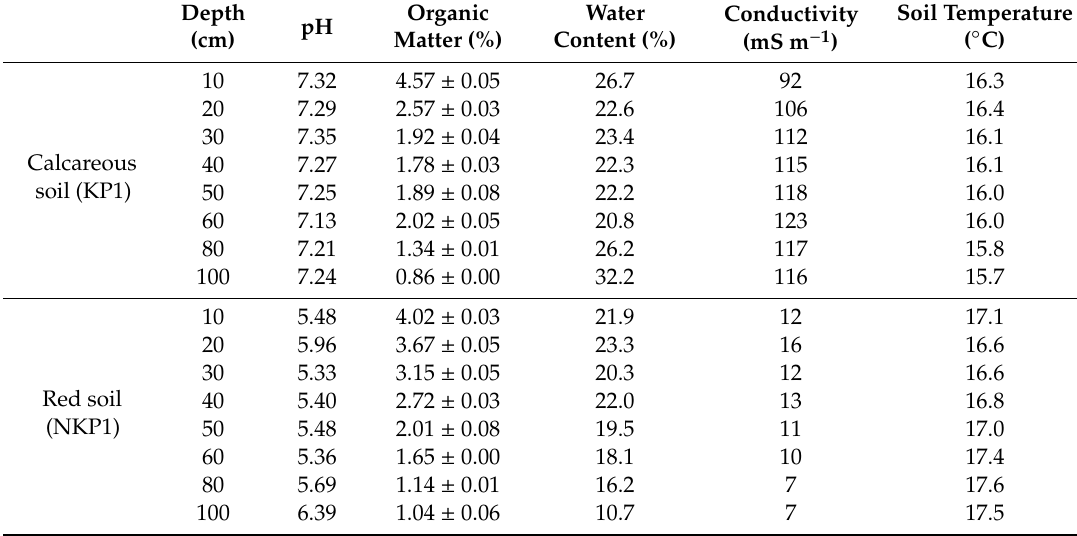
Table 1. Properties at different depths in calcareous and red soils.